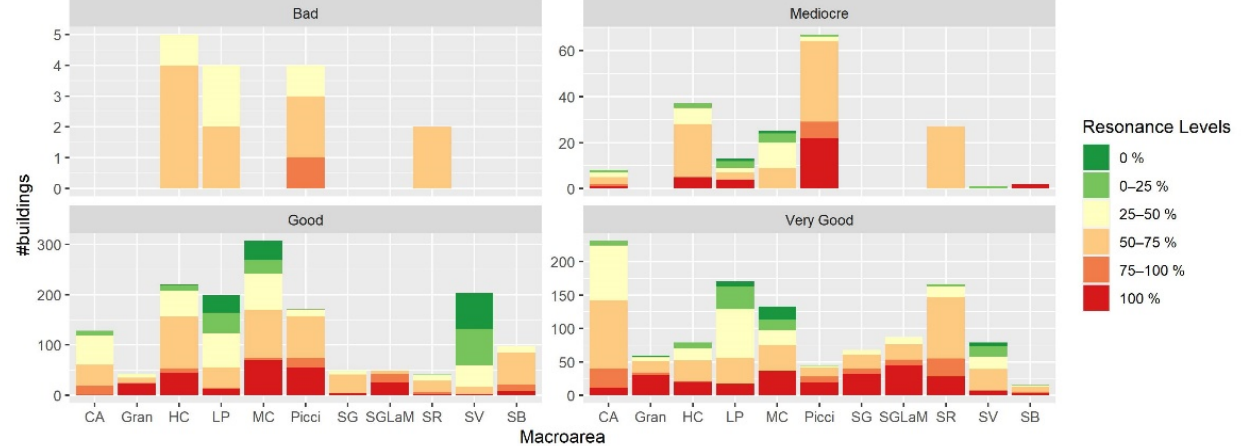
Figure 15. Bar charts showing the number of buildings for each macro-area, highlighting the probability levels of resonance occurrence and the building state of conservation. CA: Cappuccini-Agna; Gran: Granulari; HC: Historic Centre; LP: Lanera-Pini; MC: Macamarda-Castello; Picci: Piccianello; SG: San Giacomo; SGLaM: San Giacomo-Via La Martella; SR: Serra Rifusa; SV: Serra Venerdì; SB: Spine Bianche.